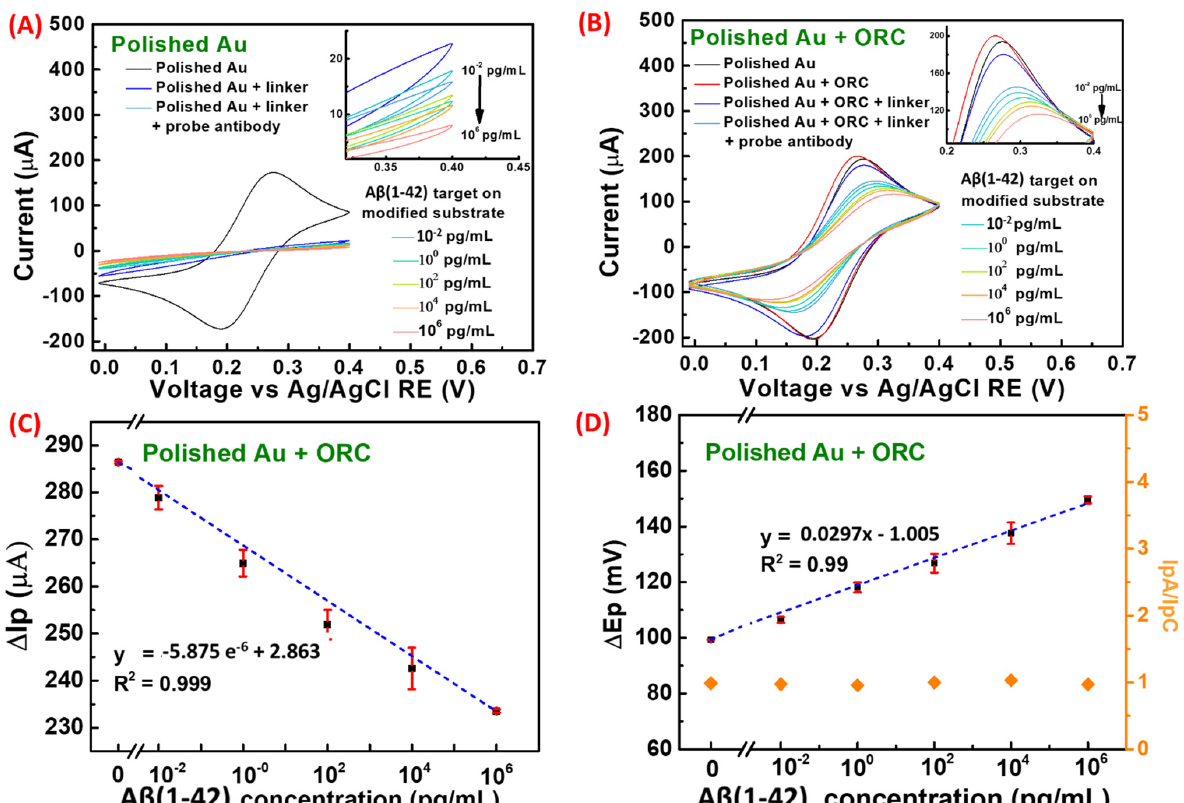
Figure 5. Cyclic voltammogram (CV) of polished gold ( A ) without and ( B ) with ORC for of A β (1–42) peptide detection. Inset shows the enlarged anodic peak current ( ∆ Ip) trend of the CV in A β (1–42) peptide detection, which gradually decreases with increasing peptide concentration, and sensitivity plot of the ( C ) peak current ( ∆ Ip) and ( D ) peak voltage ( ∆ Ep) and IpA and IpC ratio of the polished Au with ORC treatment for A β (1–42) peptide detection.